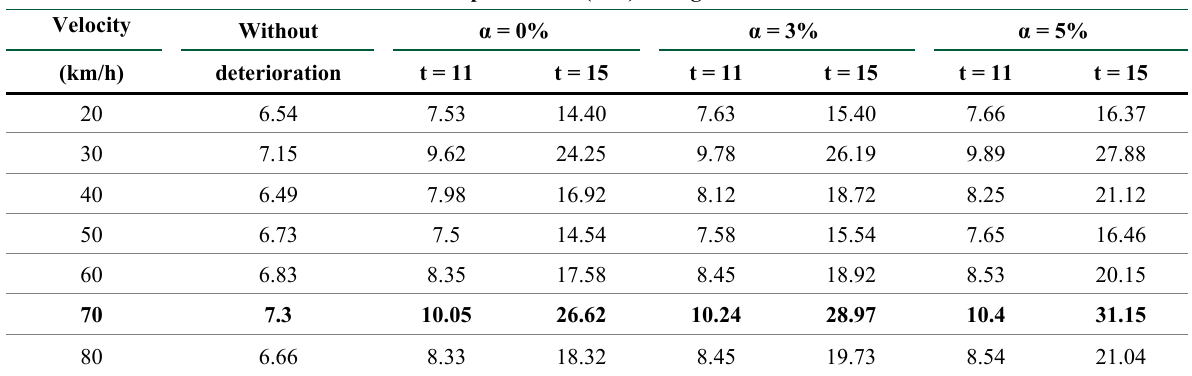
Table 4. Translational vertical displacement values (see Figure 9).